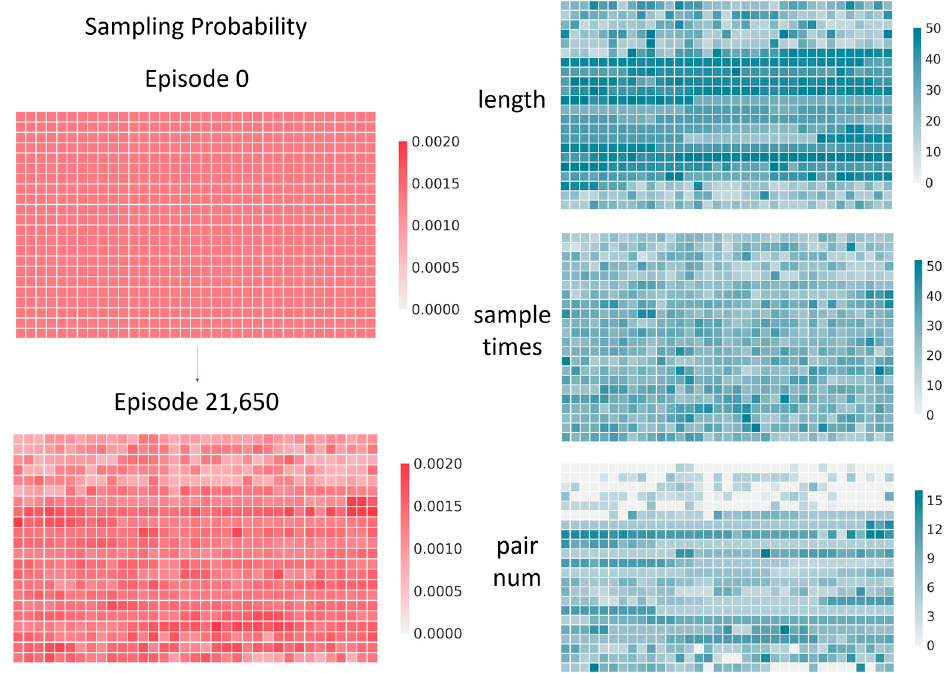
Figure 13. The sampling probability of each sample on the training set ( left ) and its length, sam- ples times, and number of base pairs ( right